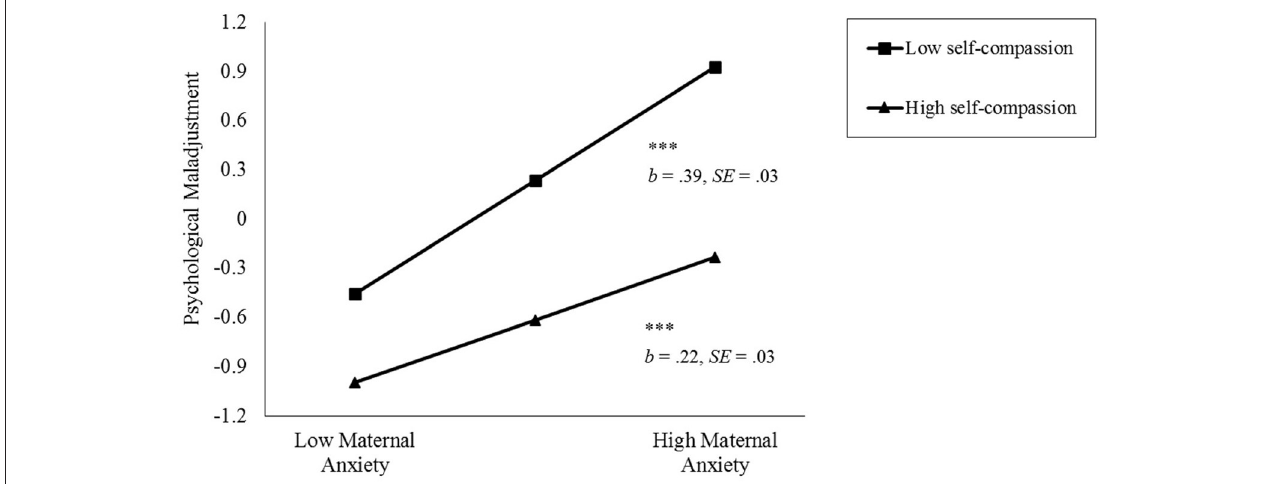
FIGURE 1 | Simple slopes of the relationship between maternal anxiety and adolescents’ psychological maladjustment at different levels of adolescents’ self-compassion. = − 88,069.21) was better than the fit of Model 0 (likelihood value = − 88,092.68), D ( df = 1) = 46.94, p < 0.001. These